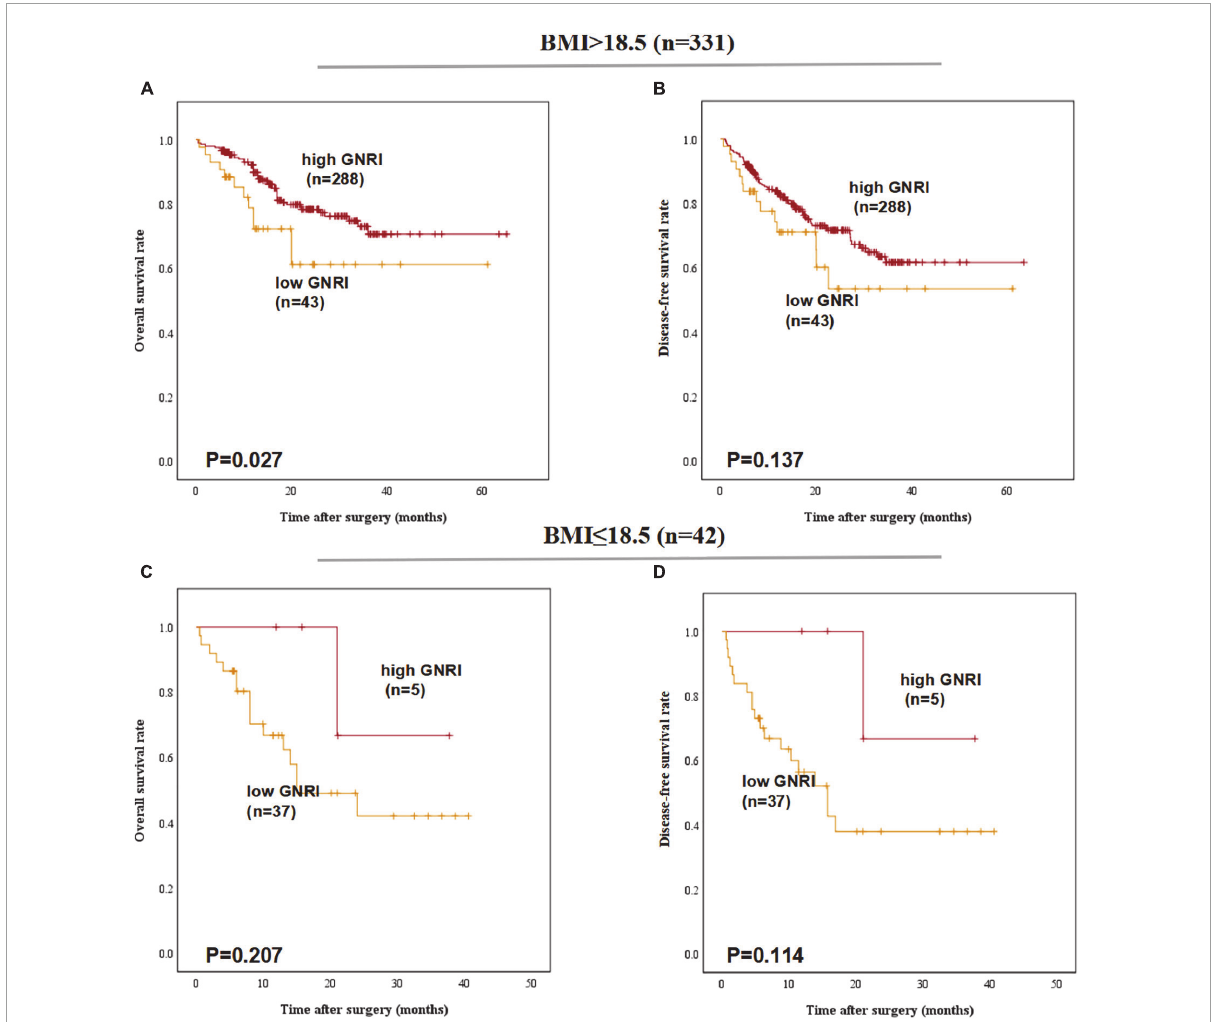
FIGURE2 Postoperative outcomes of patients with high or low geriatric nutritional index (GNRI) according to BMI: (A) overall survival, (B) disease-free survival of BMI > 18.5 patients ( n = 331), (C) overall survival, and (D) disease-free survival of BMI ≤ 18.5 patients ( n =